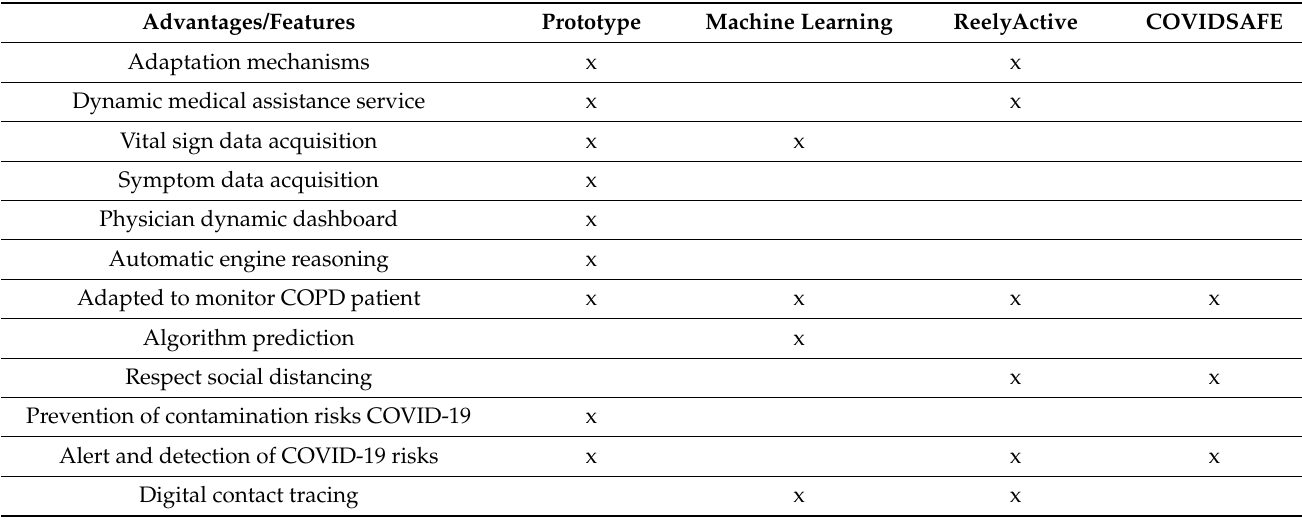
Table 10. Table of comparison for prototype, machine-learning approaches, and other alert